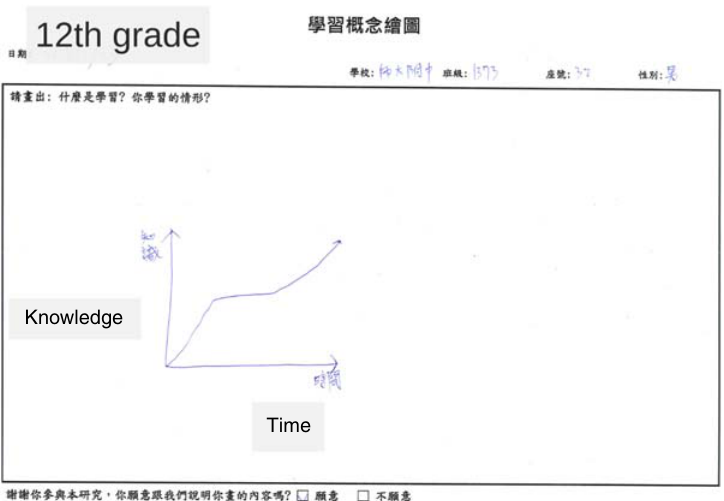
Figure 4. A drawing by a